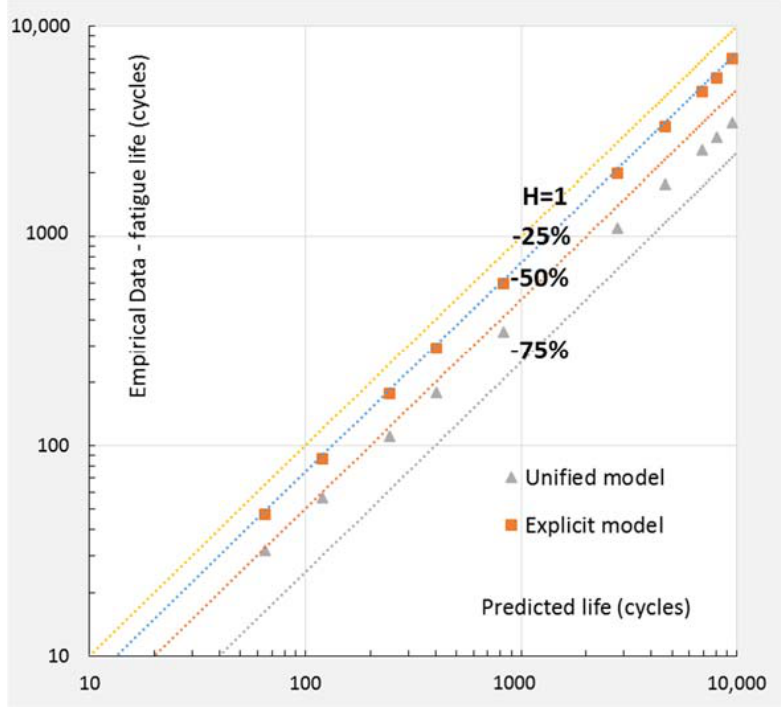
Figure 9. Prediction ratio for stainless steel 316 at pure fatigue.